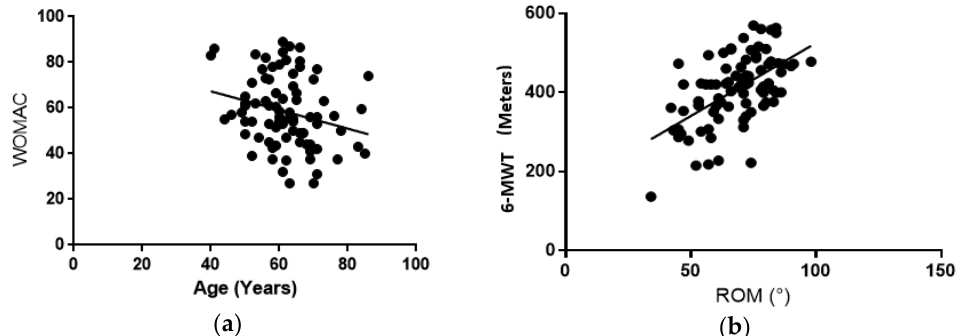
Figure 2. Right panel ( a ): WOMAC score vs. age. As participants aged, WOMAC scores decreased, (